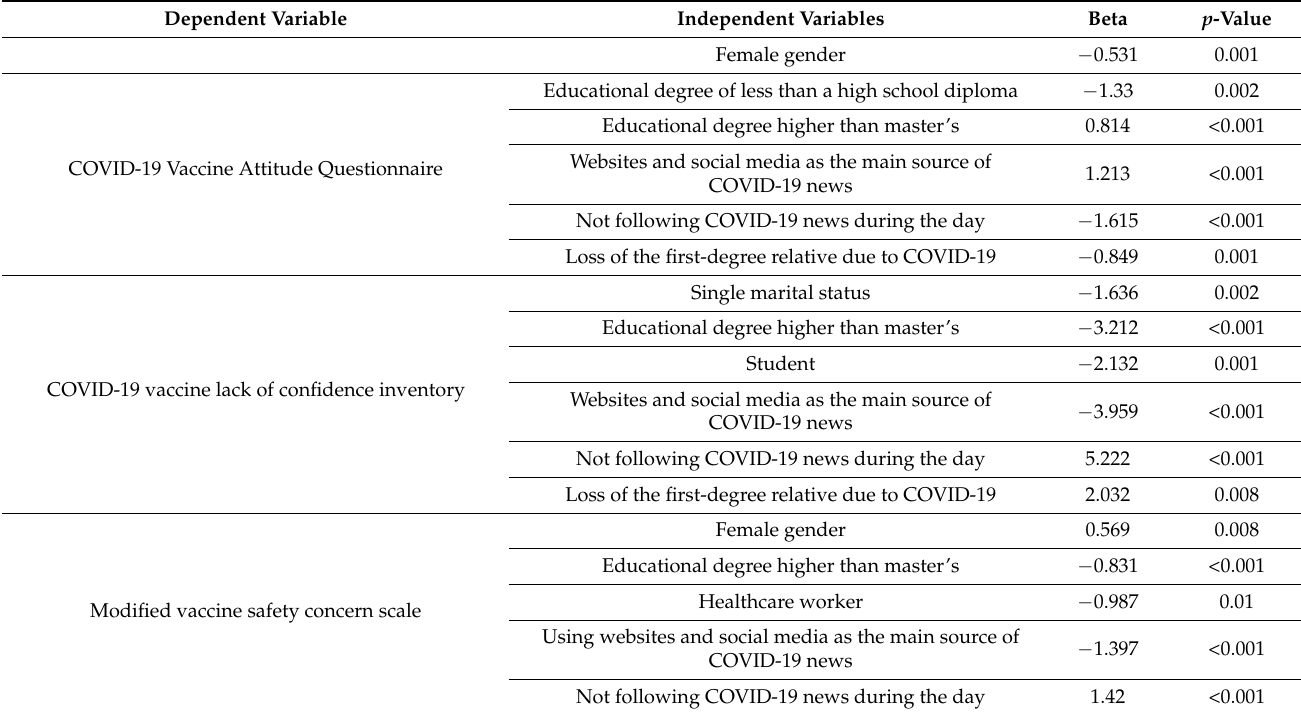
Table 3. Results of multiple linear